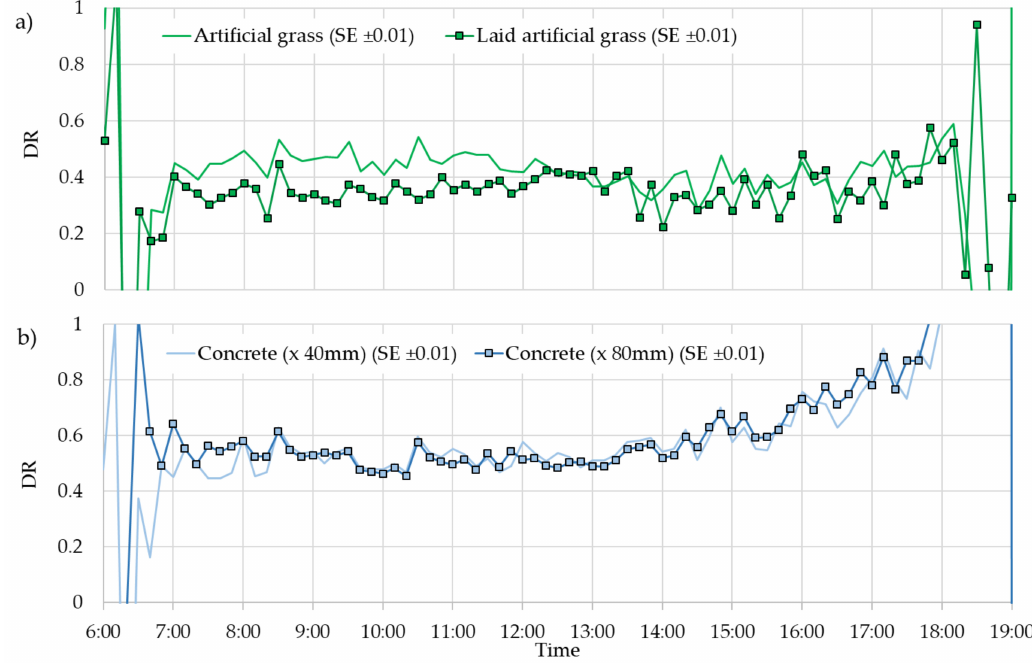
Figure 8. Daytime ratio (T iB,LE –T amb ) over (T iB,WPP –T amb ) for LEs, summer 2018. Comparison of: ( a ) low thermal inertia artificial grass with higher thermal inertia laid artificial grass; and ( b ) lower thermal inertia concrete × 40 mm with higher thermal inertia concrete × 80 mm. Data from 09:00 to 15:40 were averaged. Standard errors (SE) were calculated assuming random errors and a normal distribution